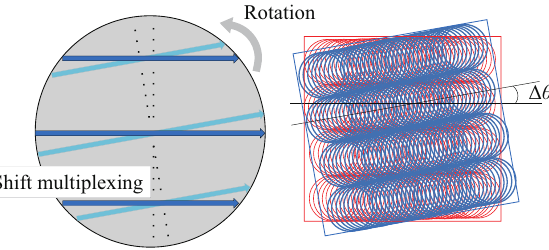
Figure 4. The recording method to the disk-shaped